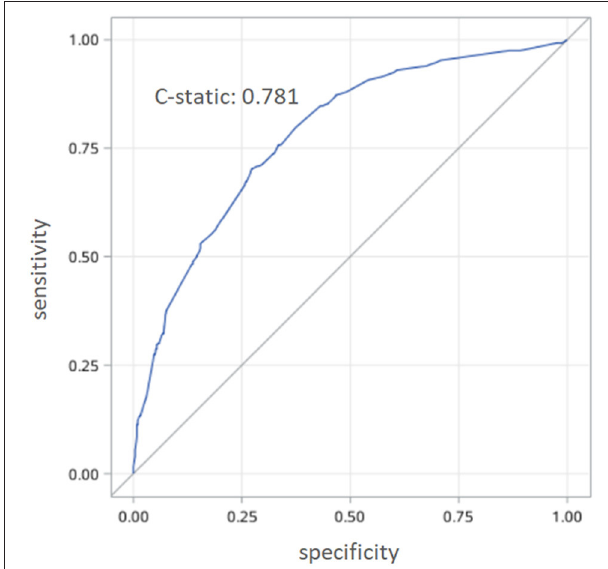
FIGURE 2 | The receiver operating characteristic (ROC) analyses of the prediction model.